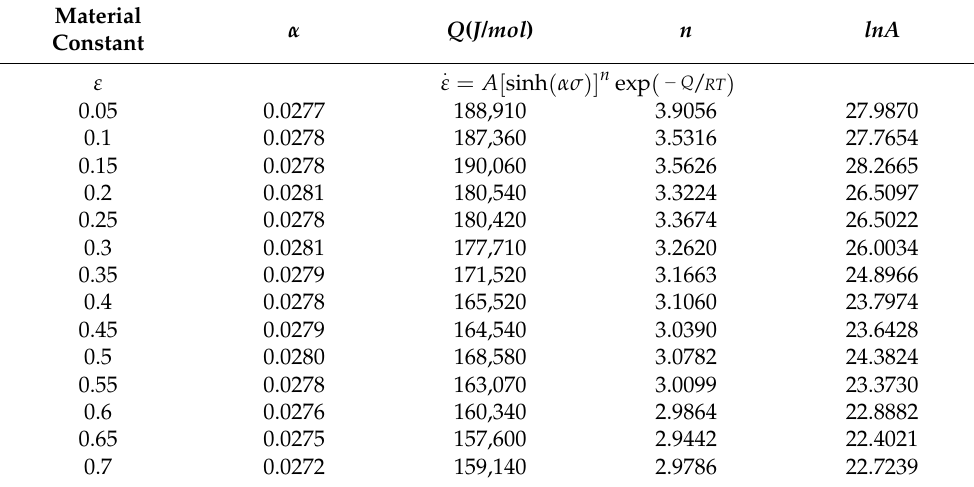
Table 3. Calculated material constants ( α , Q , n and ln A ) of as-extruded Mg–6Zn–5Ca–3Ce alloy fabricated by